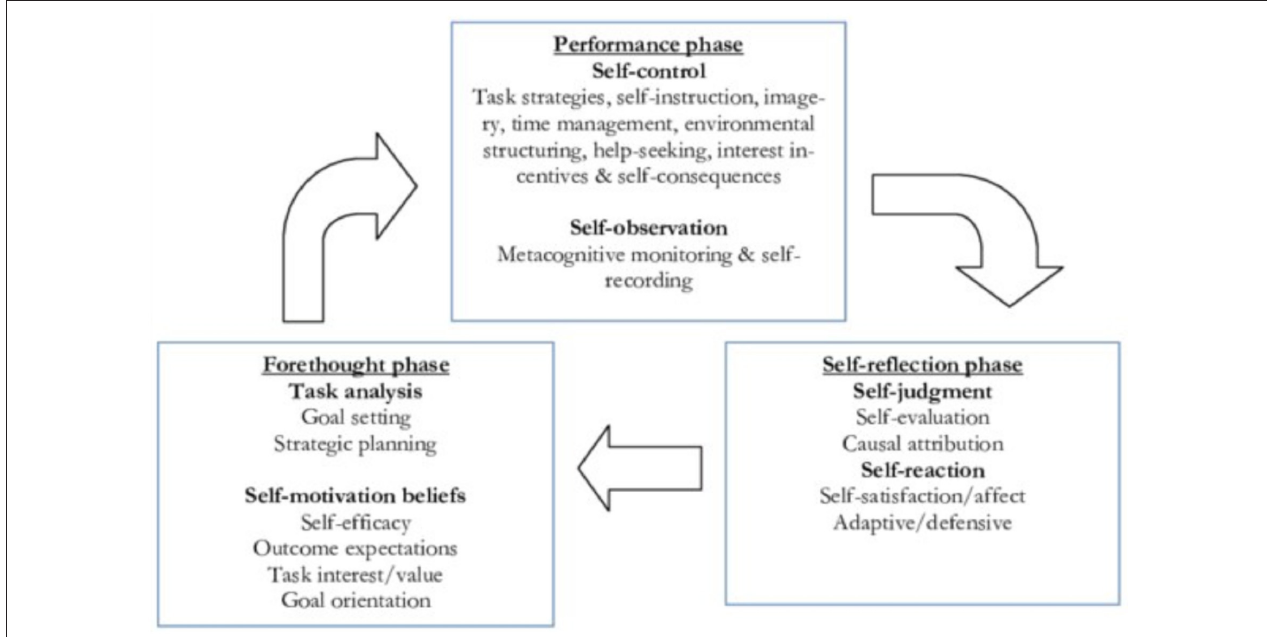
FIGURE 1 | Zimmerman’s model of